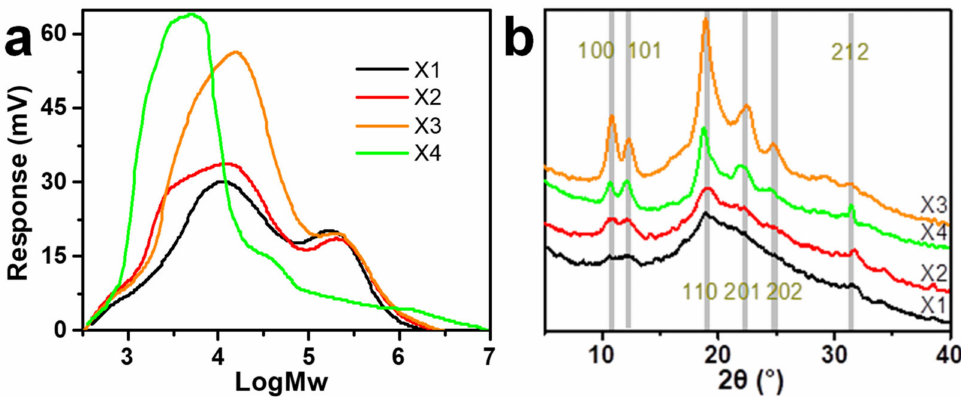
Figure 1. ( a ) Molecular weight distribution and ( b ) XRD profiles of different xylan